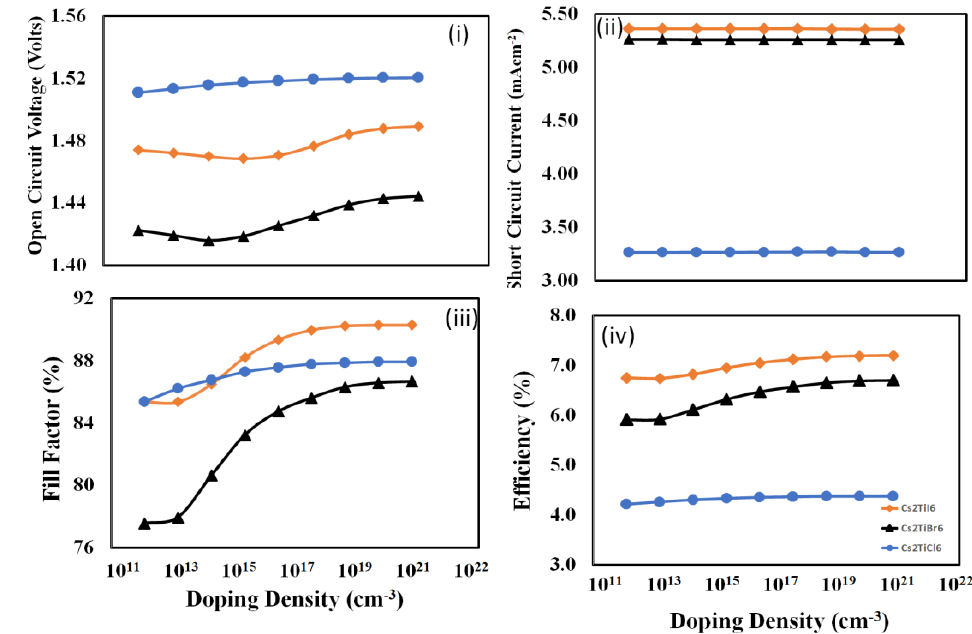
Figure 6. The photovoltaic response parameters: ( i ) open-circuit voltage, ( ii ) short-circuit current, ( iii ) fill-factor, and ( iv ) power-conversion efficiency as a function of the doping density of Nb 2 O 5 (electron-transport layer) for the proposed devices Cs 2 TiCl 6 , Cs 2 TiBr 6 , and Cs 2 TiI 6 respectively.